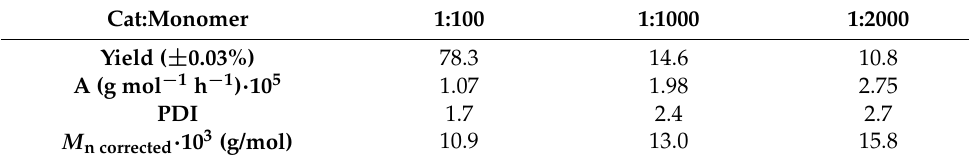
Table 3. Polymerization results for the ROP of ε -caprolactone mediated by complex 4